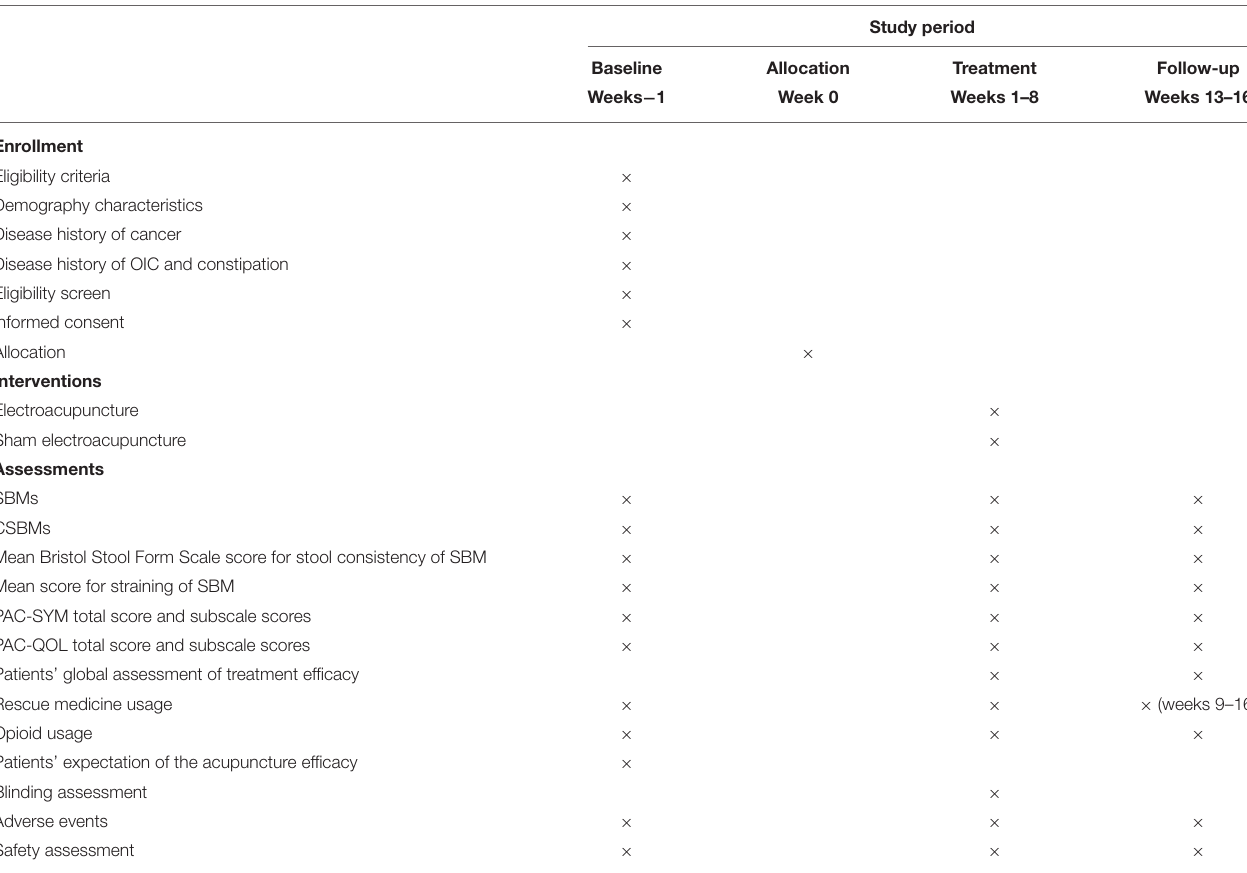
TABLE 1 | The time frame of